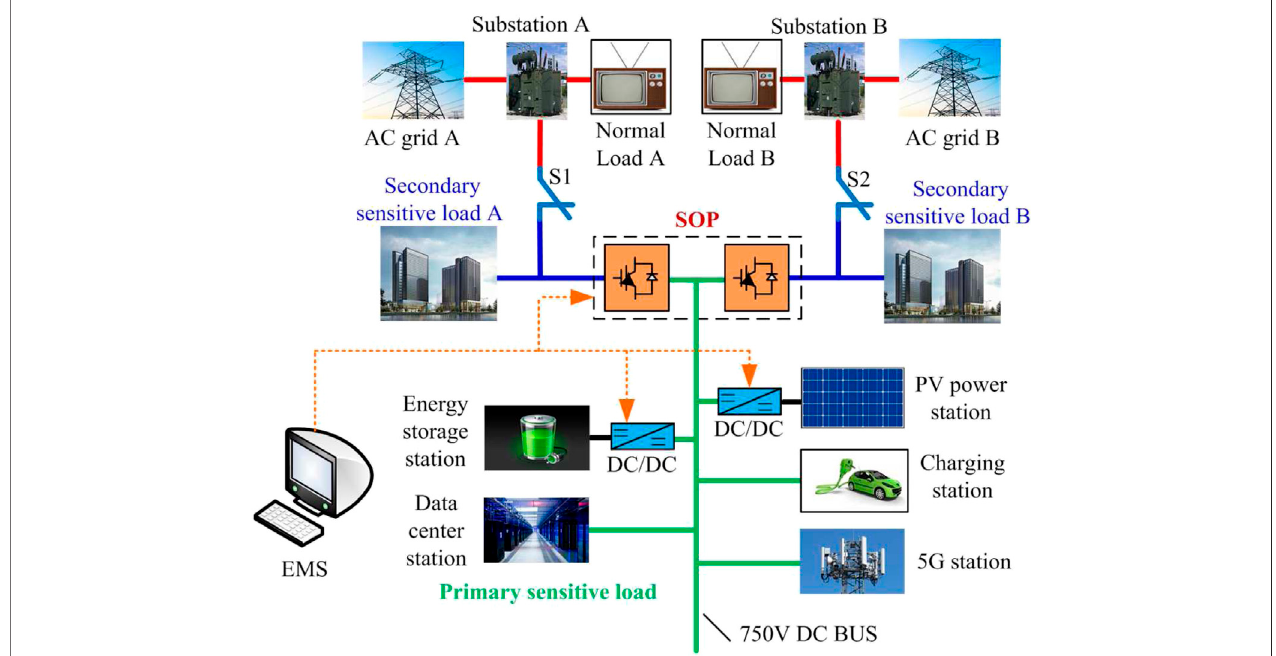
FIGURE 1 | Multi-station integration